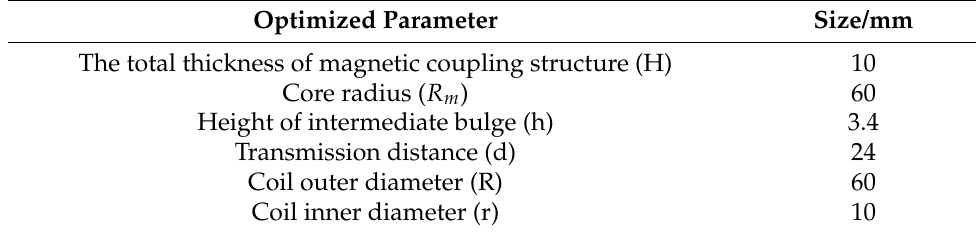
Figure 7. Changes of mutual inductance with R and r . Table 3. Optimized parameters of the proposed